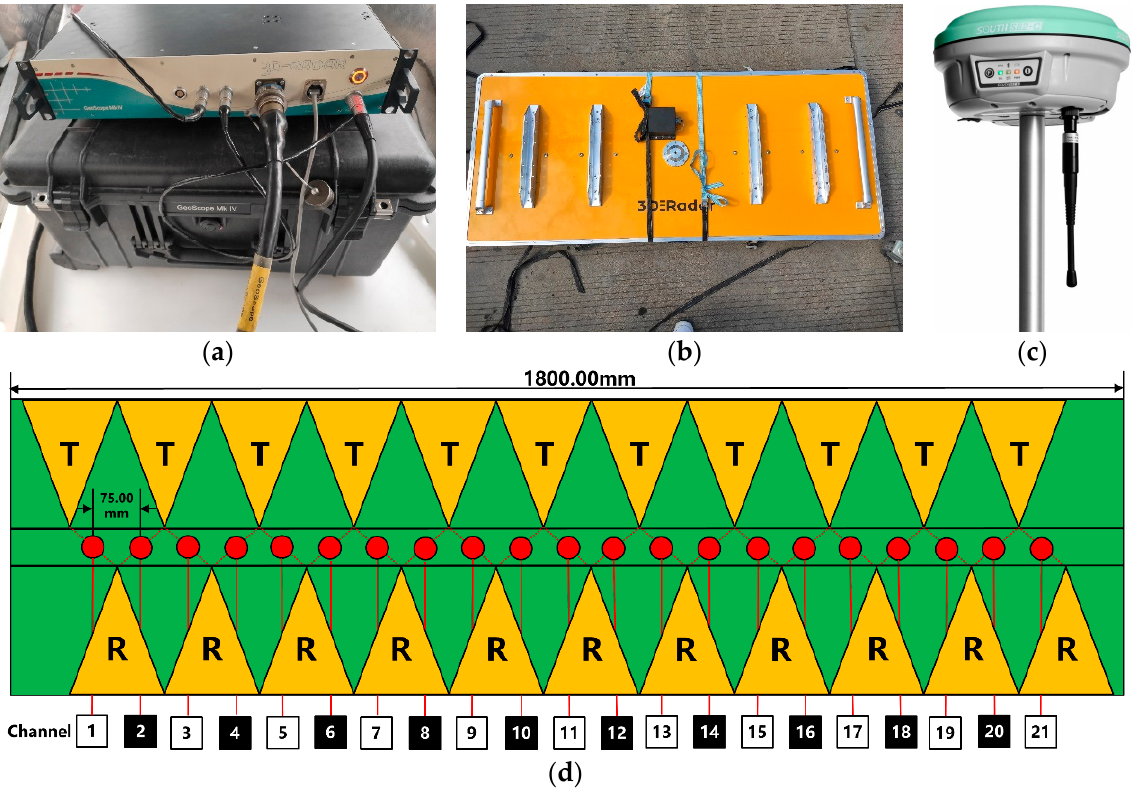
Figure 4. ( a ) GeoScope TM MKIV, ( b ) DXGTM 1820 ground-coupled antenna arrays, ( c ) GPS-RTK, and ( d ) transmit and receive arrays of Radar.